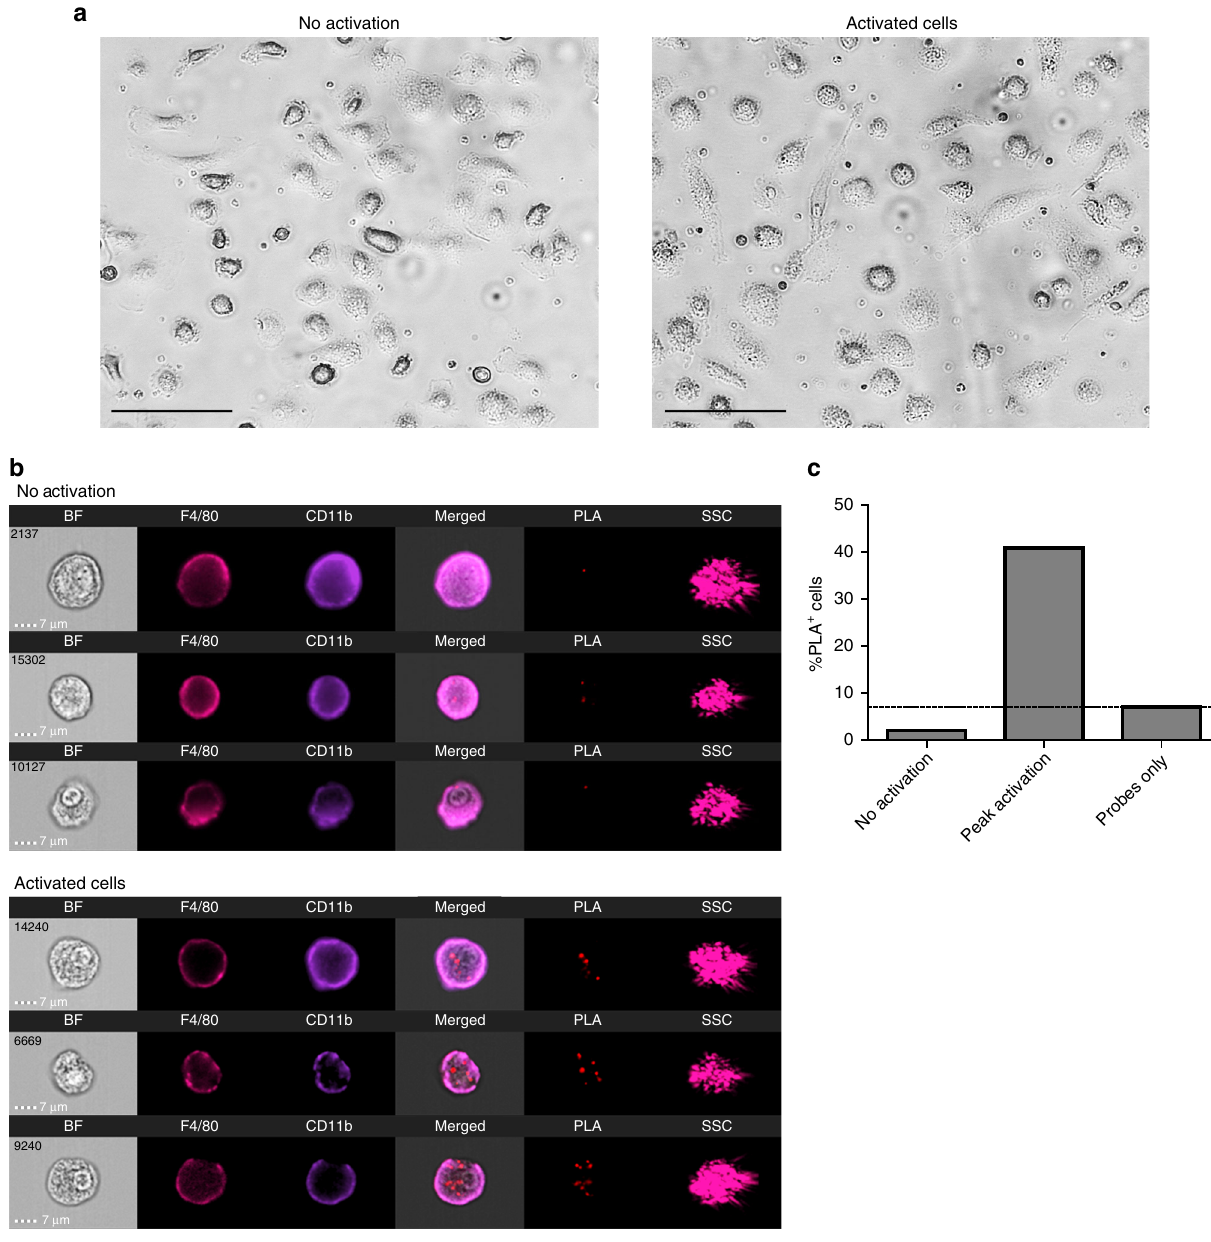
Fig. 4 PLIC analysis of caspase-1 oligomerization in NLRP3 in fl ammasome-activated bone-marrow derived macrophages (BMDM). a Light microscopy images (x20) of non-activated BMDM and NLRP3 in fl ammasome-activated (LPS + ATP) BMDM. Scale bar 100 μ M b Representative images of non- activated and NLRP3 in fl ammasome-activated BMDM, detected by PLIC, depicting median cells of the PLA bright detail intensity, and the PLA max pixel features. Cells are presented as (left to right): bright fi eld (BF), staining of F4/80 (PE/Cy7), CD11b (PB), BF/PLA/F4/80/CD11b overlay (merged), PLA (FarRed), and side scatter (SSC). Scale bar 7 μ M. c Quantitative analysis of caspase-1 oligomerization (presented as the percentage of PLA + cells) in non- activated cells, cells at peak activation, and probes only control. Representative of four independent experiments with similar results, calculated from 20,000 cells (F4/80 + CD11b + ) per treatment (no activation/ NLRP3 in fl ammasome activation by LPS +